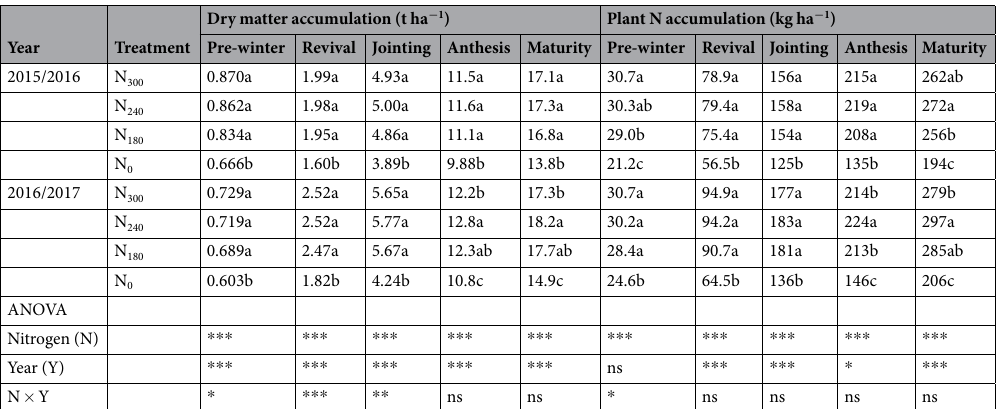
Table 1. Dry matter accumulation and plant N accumulation of wheat at different growth stages under different N treatments in 2015/2016 and 2016/2017 (kg ha − 1 ). N 300 , N 240 , N 180 and N 0 represent N application rate at 300, 240, 180 and 0 kg N ha − 1 , respectively. Different letters indicate statistical significance at P < 0.05 among treatments. * Significant at P < 0.05. ** Significant at P < 0.01. *** Significant at P < 0.001. ns, not significant, P ≥